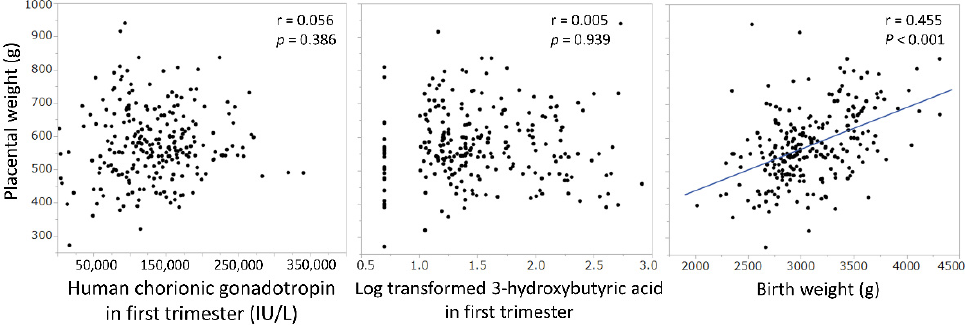
Figure 5. Correlation of placental weight with serum levels of human chorionic gonadotropin and 3-hydroxybutyric acid, and birth